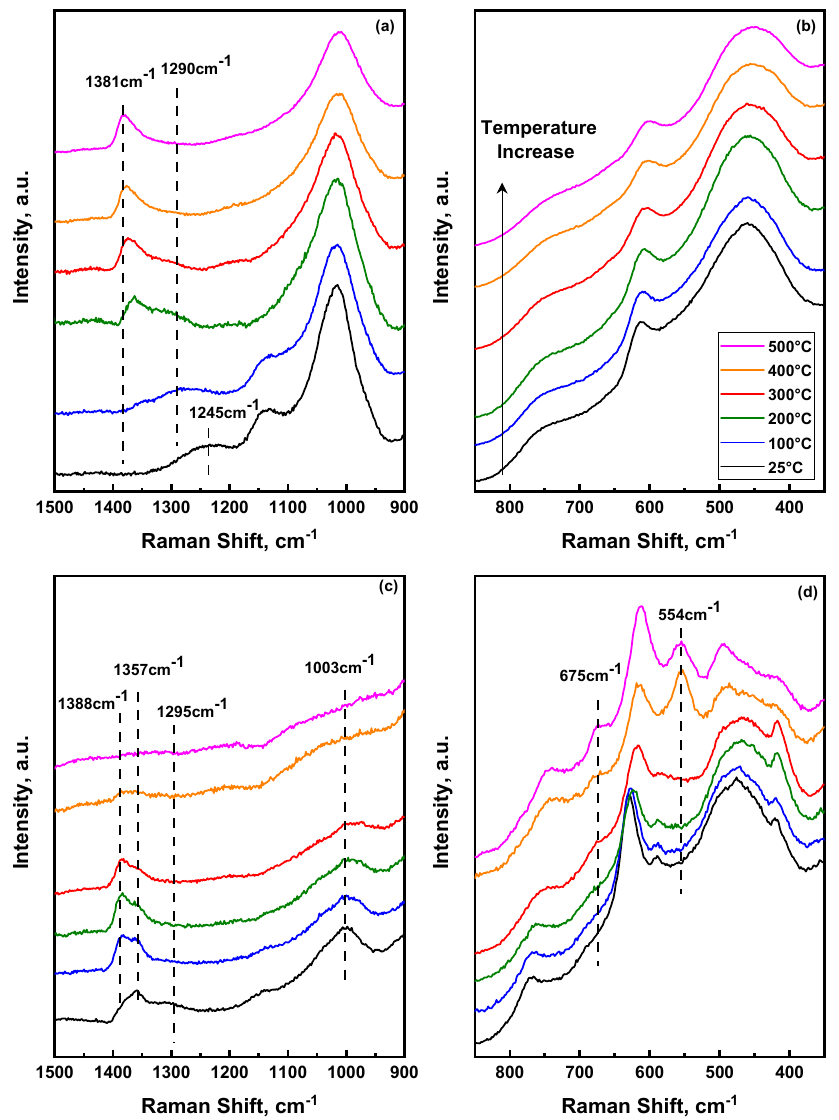
Figure 5. Temperature dependent Raman spectra of the ( a,b ) 1:1 (SO 42− )SnO 2 /ZrO 2 , and ( c,d ) (SO 42− )SnO 2 up to 500 °C. Acquisition time was set to 60 secs, while 32 accumulations have been used to increase signal/noise ratio. A 10X long working distance objective was used at a slight defocused mode to avoid local overheating